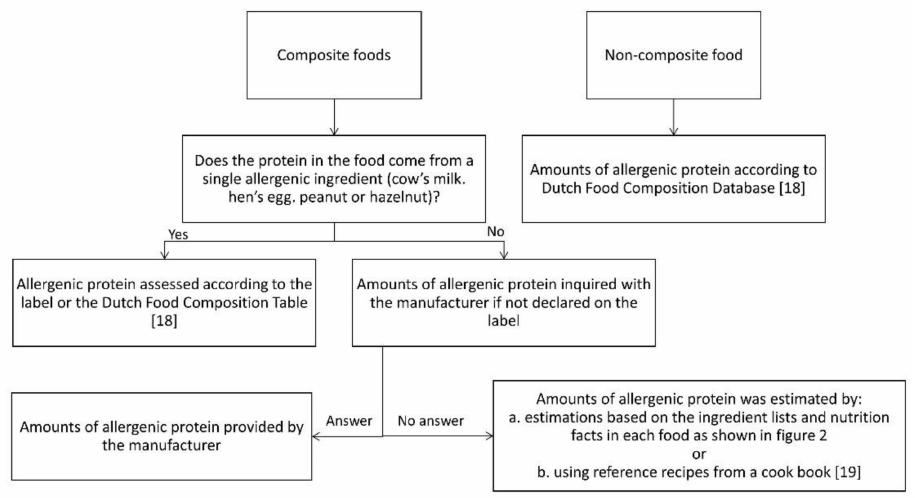
Figure 1. Assessment of the amount of allergenic protein